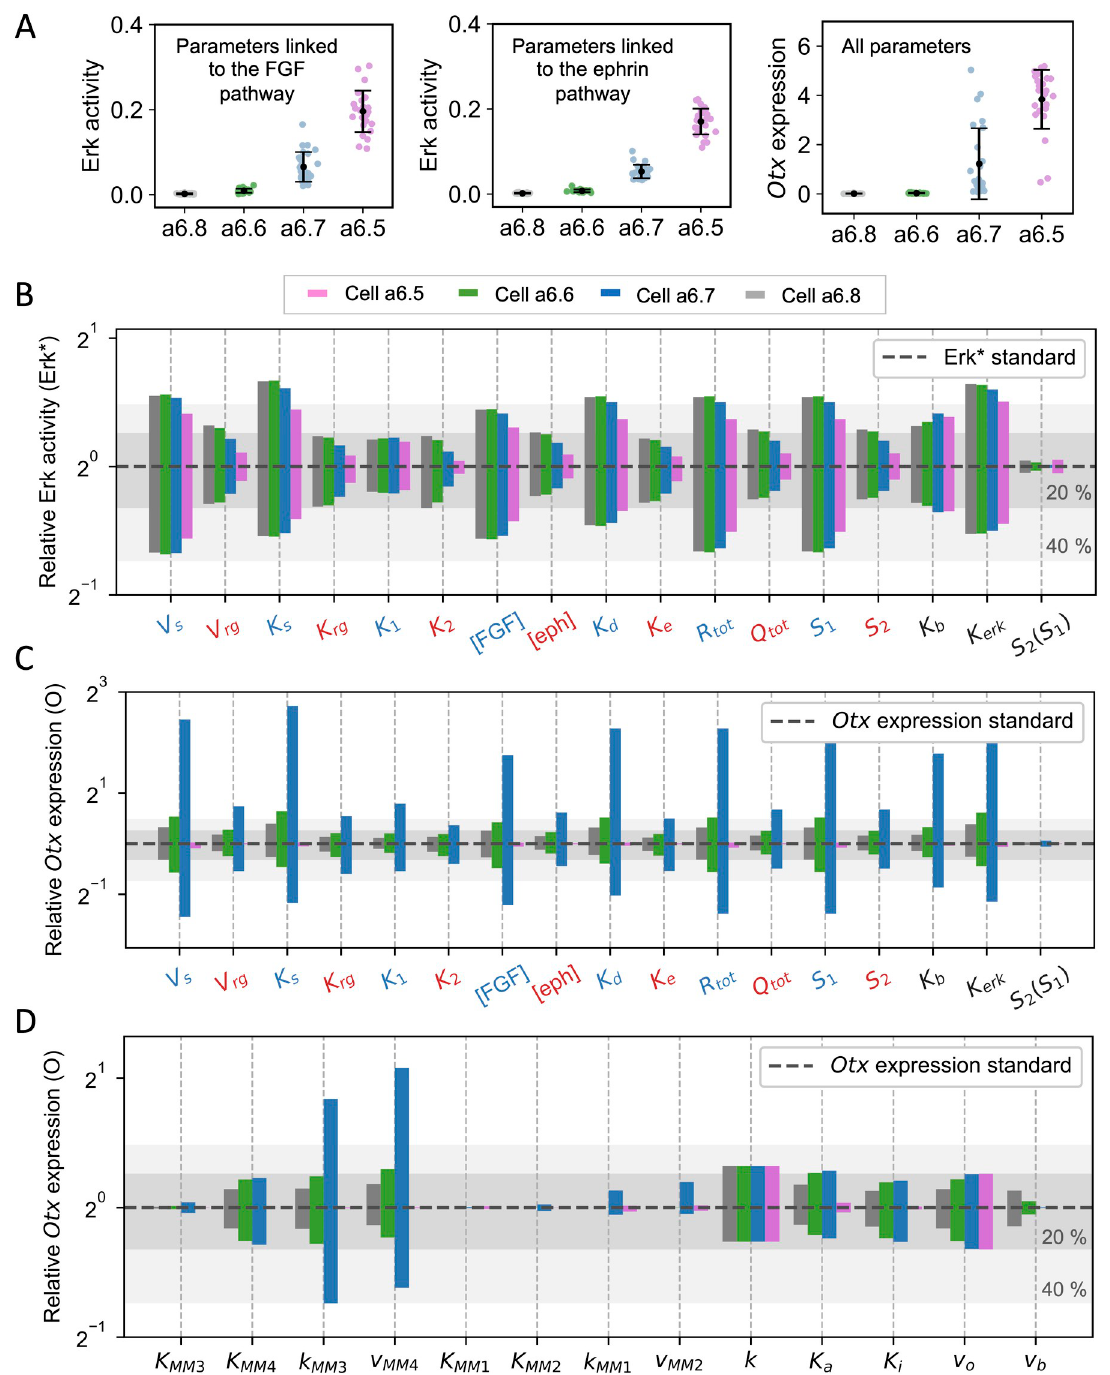
Fig 4. Sensitivity analysis. (A) On the left: levels of ERK activation (Erk � ) in a6.5, a6.6, a6.7 and a6.8 cell types computed with the model when randomly varying the values of the parameters linked to the FGF pathway ([FGF], K d , K 1 , K s , V s , R T ) in the interval: standard value ± 20%. Middle: Erk � levels in the different cell types obtained when randomly varying the values of the parameters linked to the ephrin pathway ([ephrin], K e , K 2 , K rg , V rg , Q T ) in the interval: standard value ± 20%. Right: levels of Otx computed with the full model randomly varying the values of the parameters linked to the FGF and ephrin pathways, as above, as well as the other parameters (all the parameters in panel D plus K b and K erk ). (B) Erk � values computed when varying the value of one parameter at a time by ± 20%. Shown are the ratios between the computed values and the value obtained with the default values of parameters indicated in Table 1. Parameters affecting the SOS pathway are indicated in blue, while those affecting the p120RasGAP one are indicated in red. Results above S 1 and S